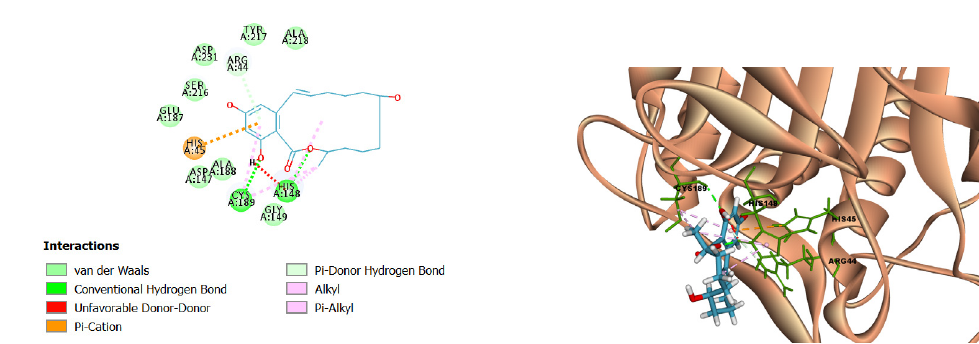
Fig. 4A. 2D diagram showing interactions of a -Zeara- lenol at LGMN catalytic